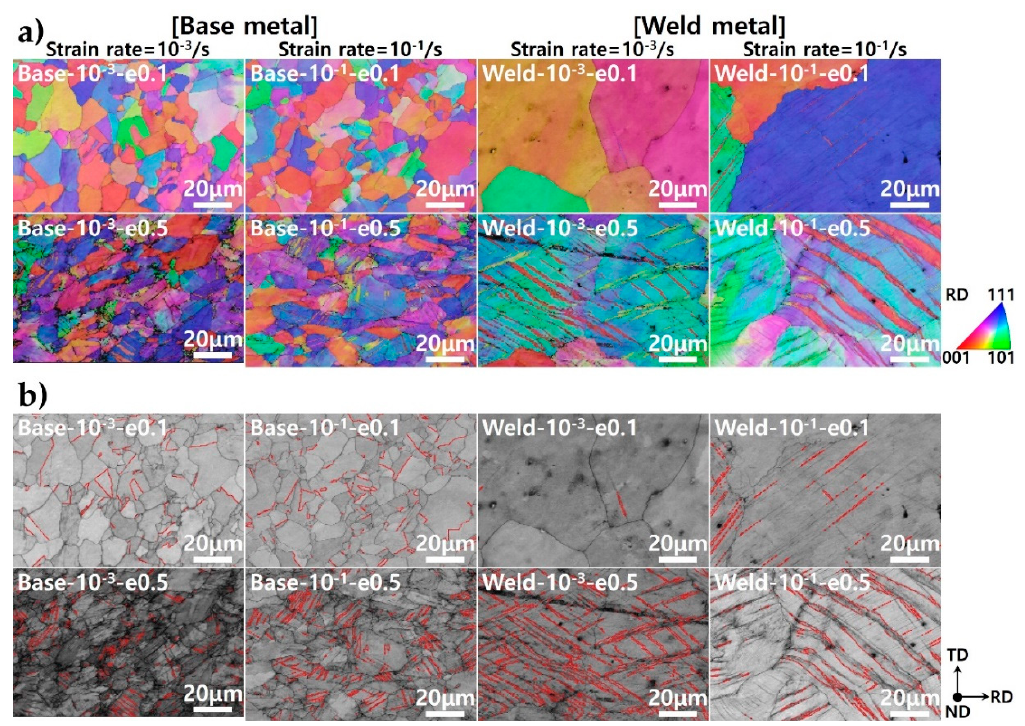
Figure 11. Tensile direction inverse pole figure (TD-IPF) EBSD maps of base metal and weld zone. ( a ) IPF maps. ( b ) Twin boundary maps. ( a ) IPF maps. ( b ) Twin boundary